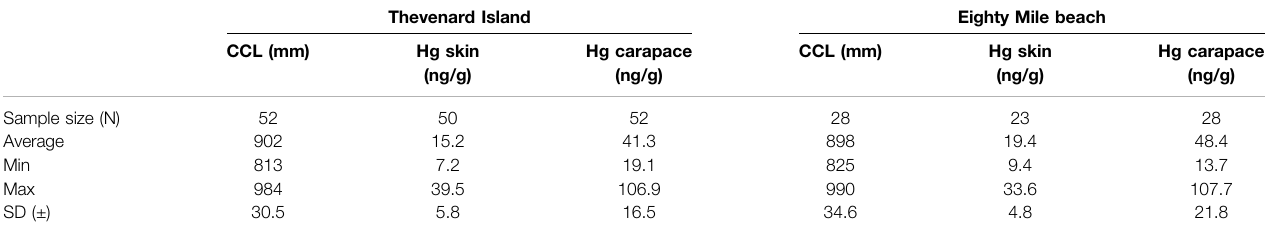
TABLE 1 | Curved carapace length (CCL, mm), Hg concentrations (ng/g) in skin and carapace of nesting fl atback turtles in rookeries from Thevenard Island and Eighty Mile Beach, WA. Thevenard